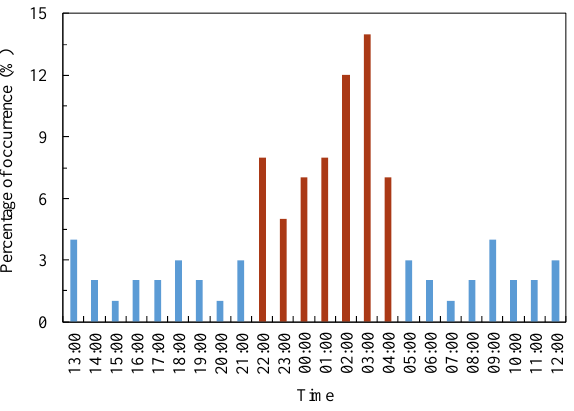
Figure 8. Temporal distribution of cracking–sliding failures in a day between 10pm and 4am.